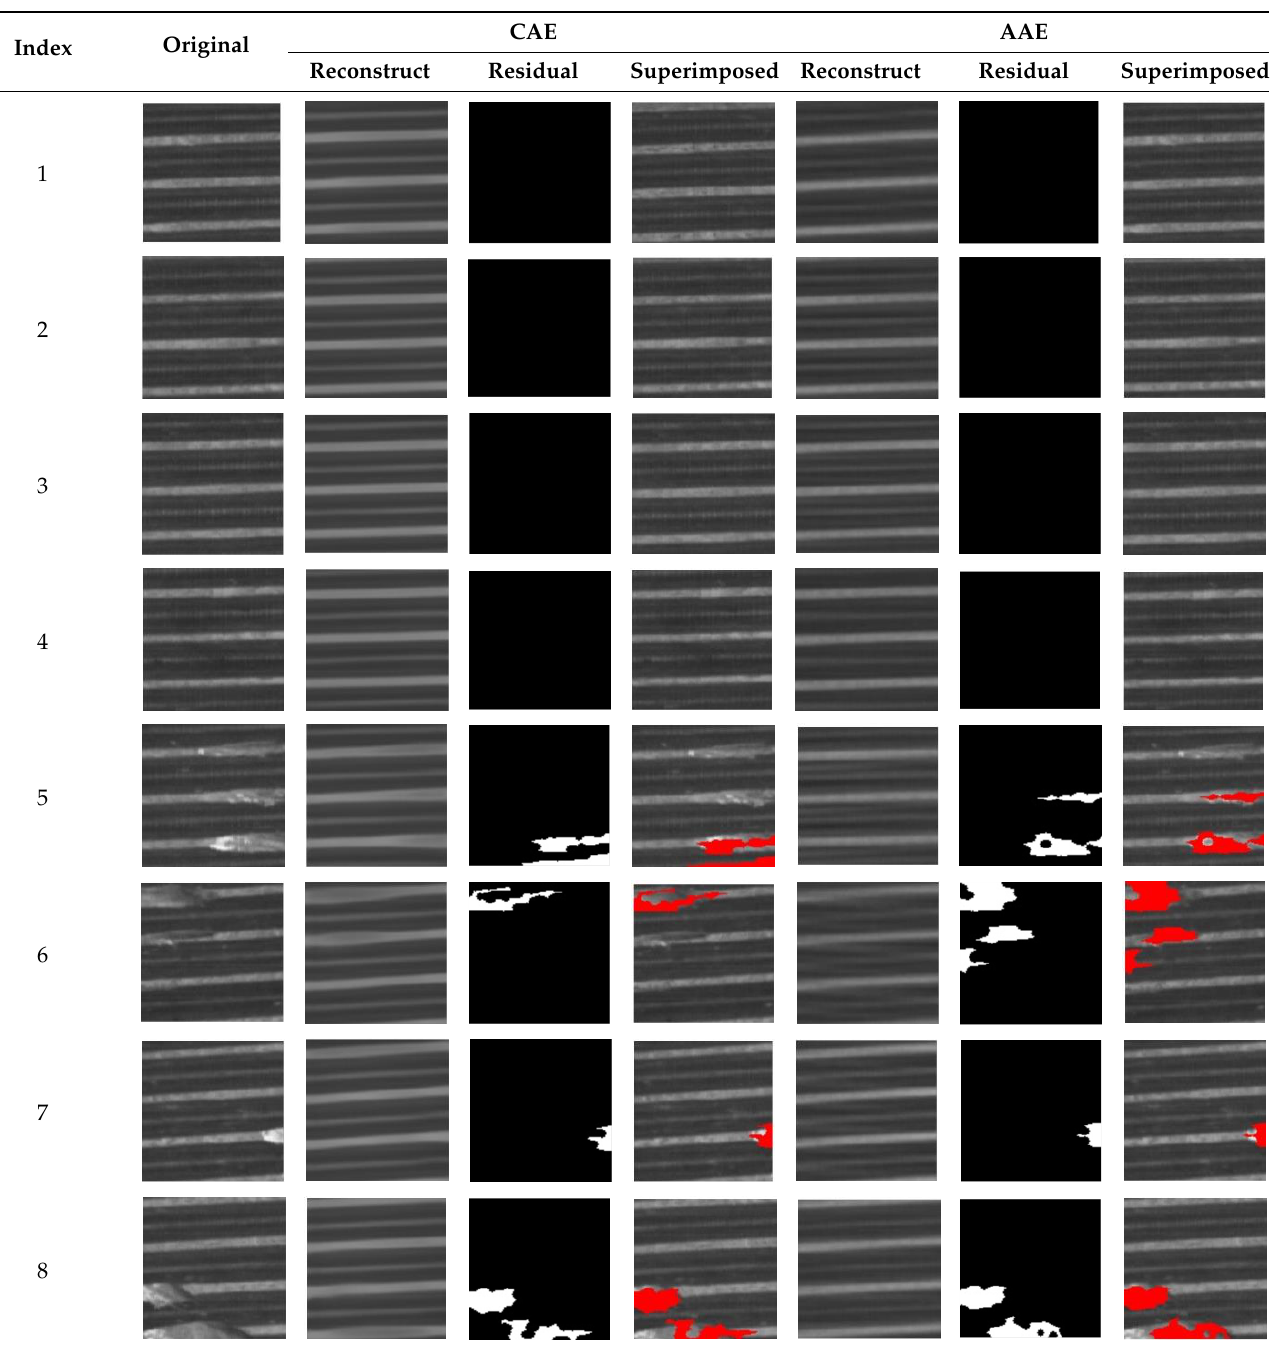
Figure 12. The meaning of the abnormal patch for two networks (unit: 0.03 mm/pixel). ( a ) Original patch image; ( b ) reconstruct patch image; ( c ) residual patch image; ( d ) superimposed patch image.